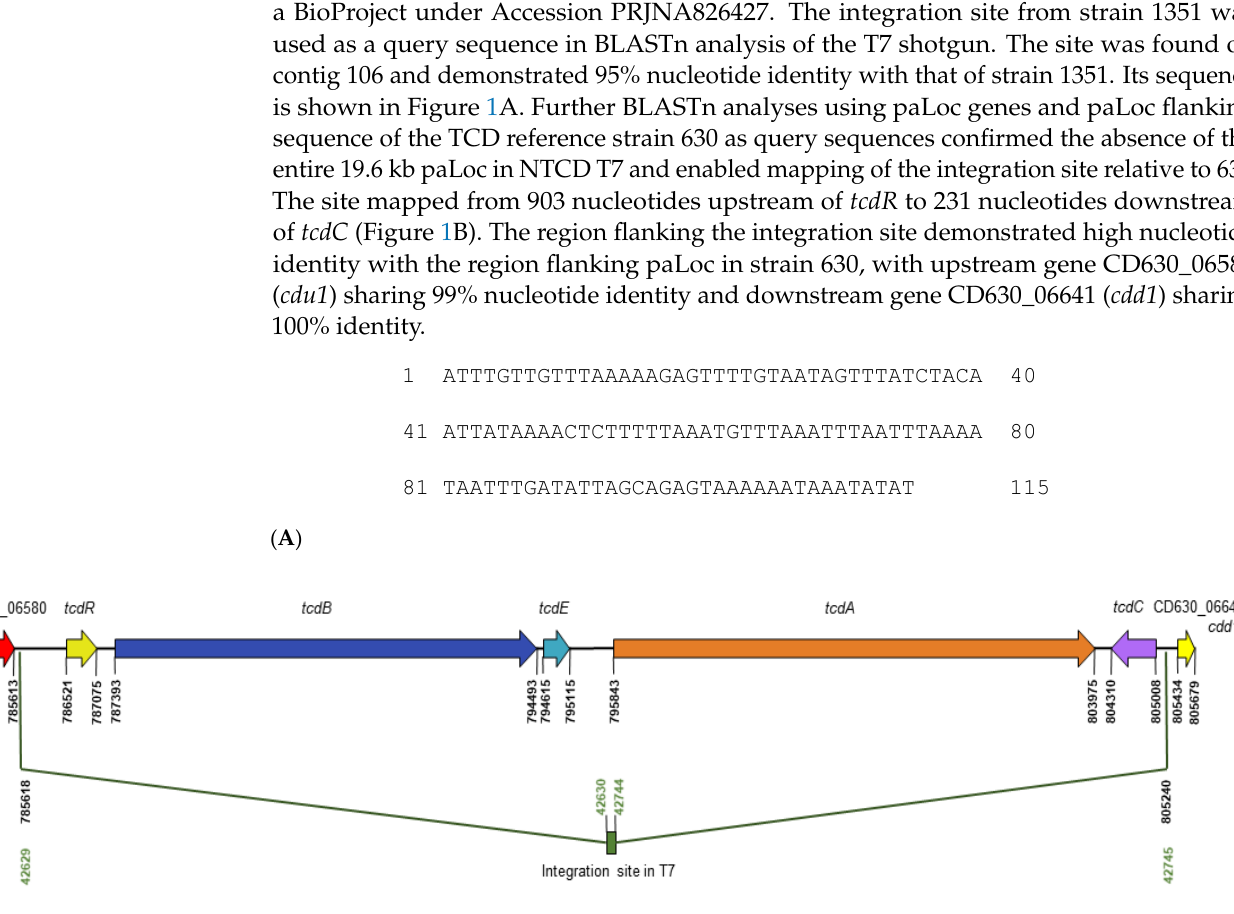
Figure 1. The identification of the 115 bp non-coding integration site in the genome of non-toxigenic C. difficile (NTCD) strain T7. ( A ) The nucleotide sequence of the integration site in T7 ( B ) Mapping of the integration site in T7 relative to the genome of the TCD reference strain, 630. The site mapped to intergenic sequence 903 nucleotides upstream of tcdR and 231 nucleotides downstream of tcdC